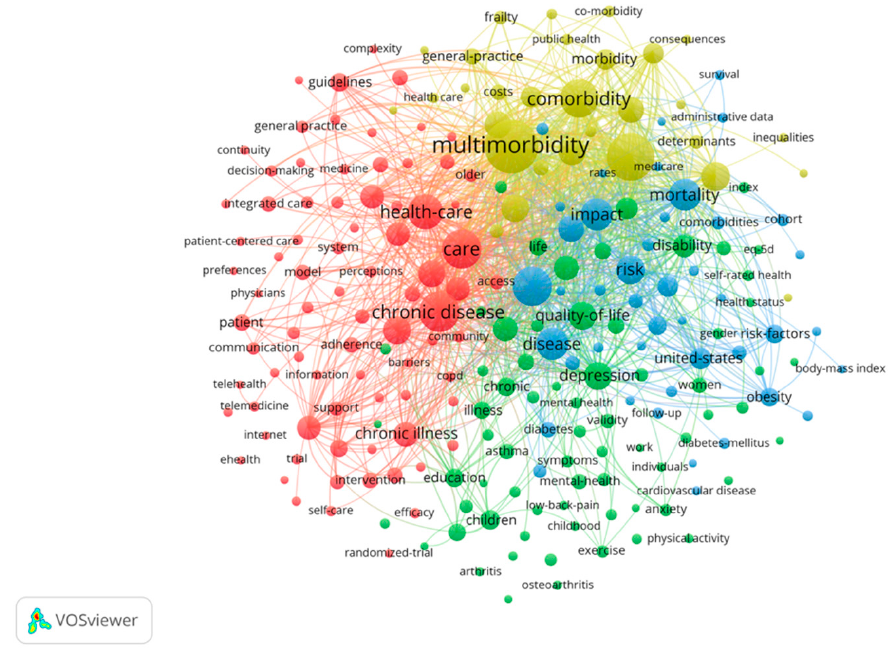
Figure 7. Co-keywords analysis of global high-frequency.